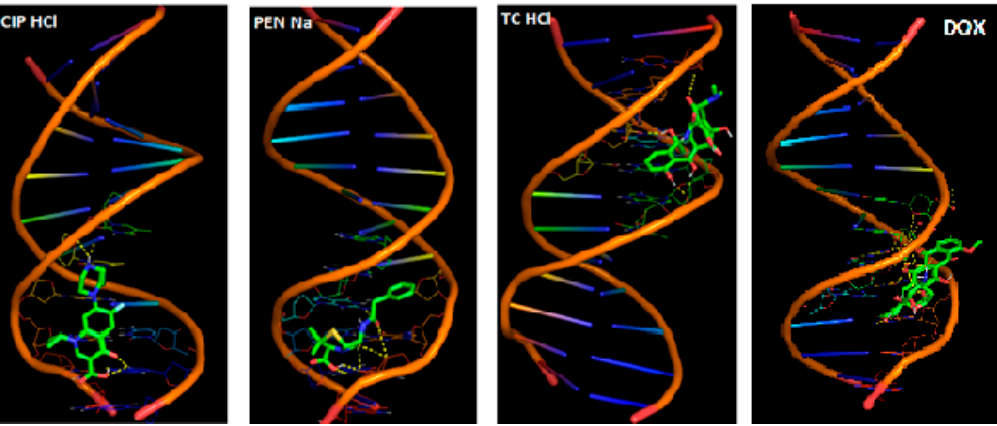
Figure 4. Binding sites of CIP·HCl , PEN·Na , TC·HCl and DOX toward DNA (PDB: 1BNA). Table 2. Calculated bonds between interacting atoms of the DNA nucleotides (d(CGCGAATTCGCG) 2 ) and the antibiotics.